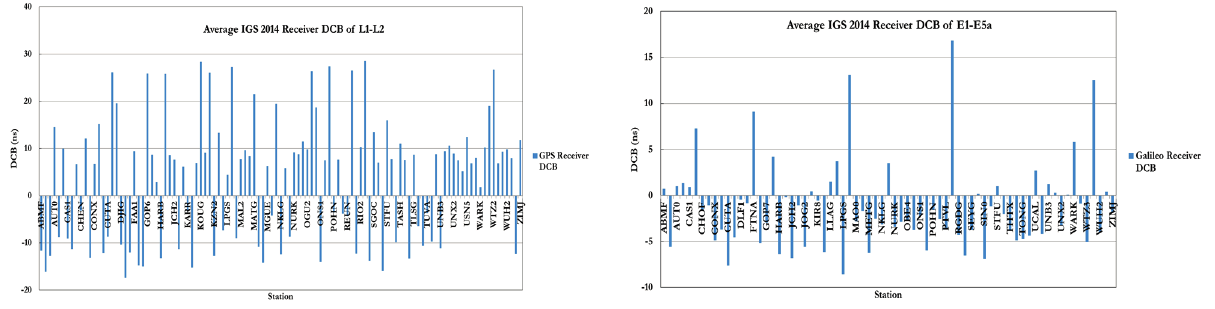
Figure 1. Average 2014 IGS receiver DCB for GPS and Galileo signals.